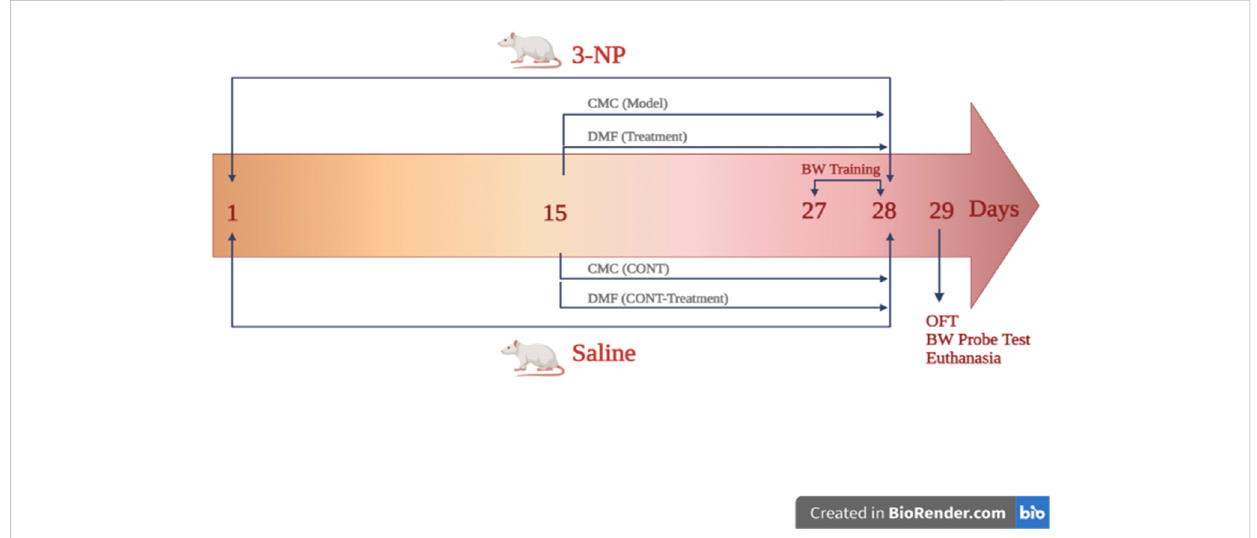
Outline of the experimental design showing the timeline for HD induction and DMF administration. On the fi rst day, rats in groups (CONT) I and (DMF)IIreceivedsalineuntilday28;onthe15thday,groupIratsadditionallyreceivedCMC,whereasthoseingroupIIwereadministeredDMF(25 mg/kg/ d,p.o) for 2 weeks.Group(HDmodel)IIIand (HD+ DMF)IVratsreceived 3-NP for 28 days with orwithout 2weeksofDMFtreatmentthatstarted onday 15. HD rats received oral CMC for 14 consecutive days initiated on day 15. On the 27th day, beam walk training was carried out for 2 days (3 trials/d/ rat) and on day 29, OF and BW tests were performed; then, rats were sacri fi ced for sampling. BW, beam walk; CMC, carboxymethyl cellulose; CONT, control; DMF, dimethyl fumarate; HD, Huntington ’ s disease; 3-NP, 3-nitropropionic acid; OF, open fi eld. The fi gure is created in